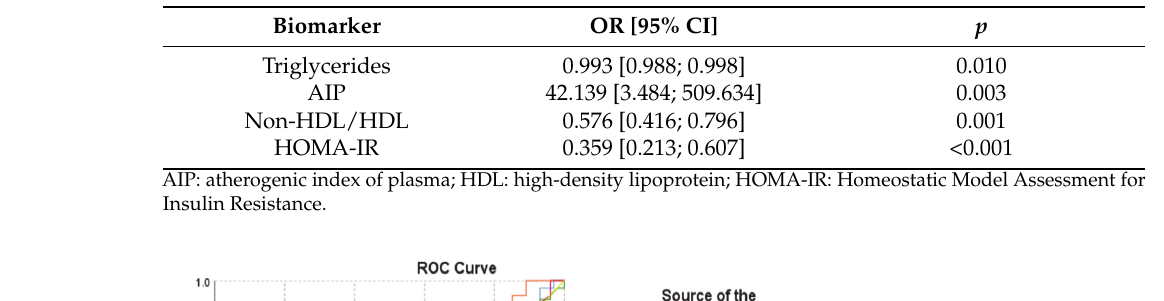
Table 4. Backward stepwise regression for the biomarkers associated with MAFLD adjusted for gender, age, T2DM duration, lipid-lowering therapy, smoking status, BMI, and WC.